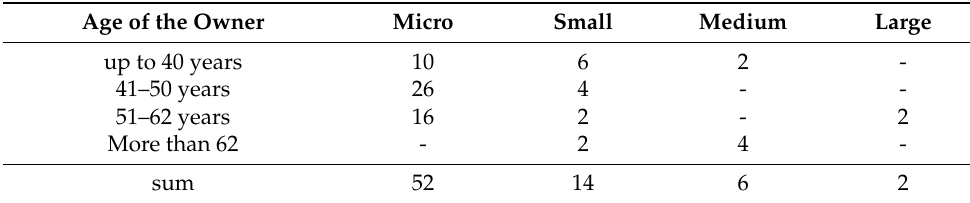
Table 2. Classification of enterprises by age of